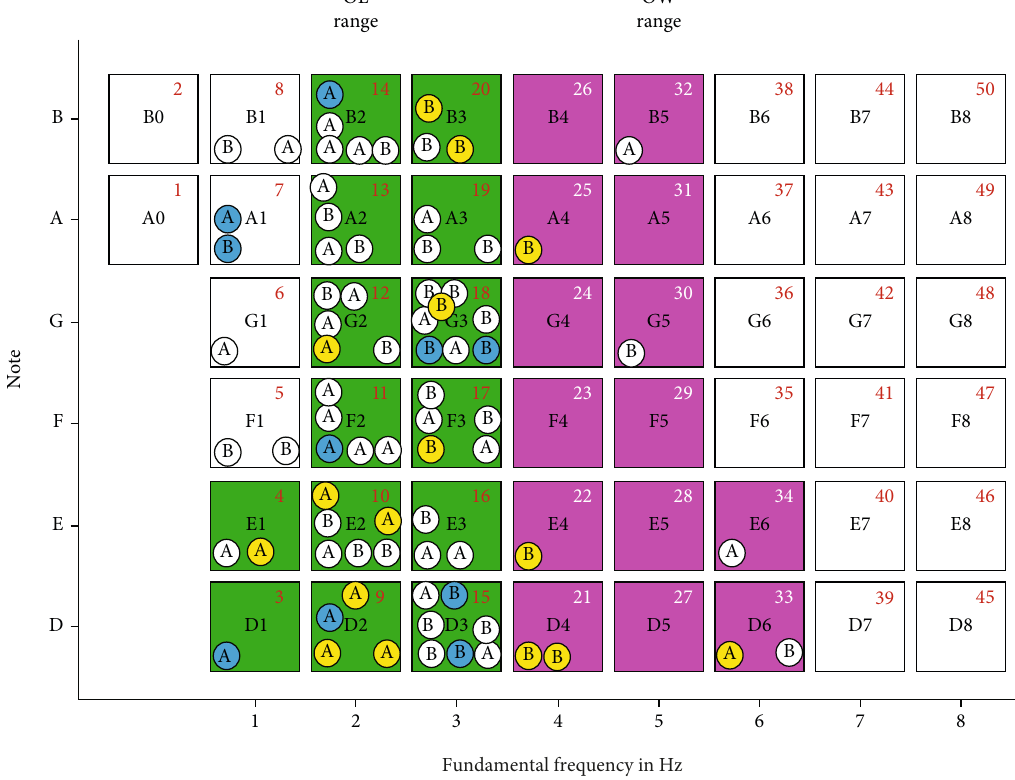
Figure 7: ASAD console of overall lowest (OL) and overall worst (OW) ranges in all cohorts. The balloons with the letter (A) represent mean results before the fatigue test, balloons with letter (B) represent mean results after the fatigue test, and the colors indicate the degree of signi fi cance; white balloons are not signi fi cant, blue were mildly signi fi cant, and yellow balloons were signi fi